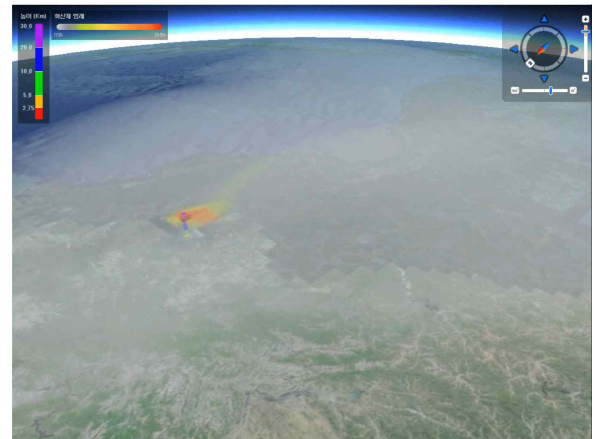
Figure 11. 3D visualization result with "Semi-transparent Volcanic Ash Plane" method-2